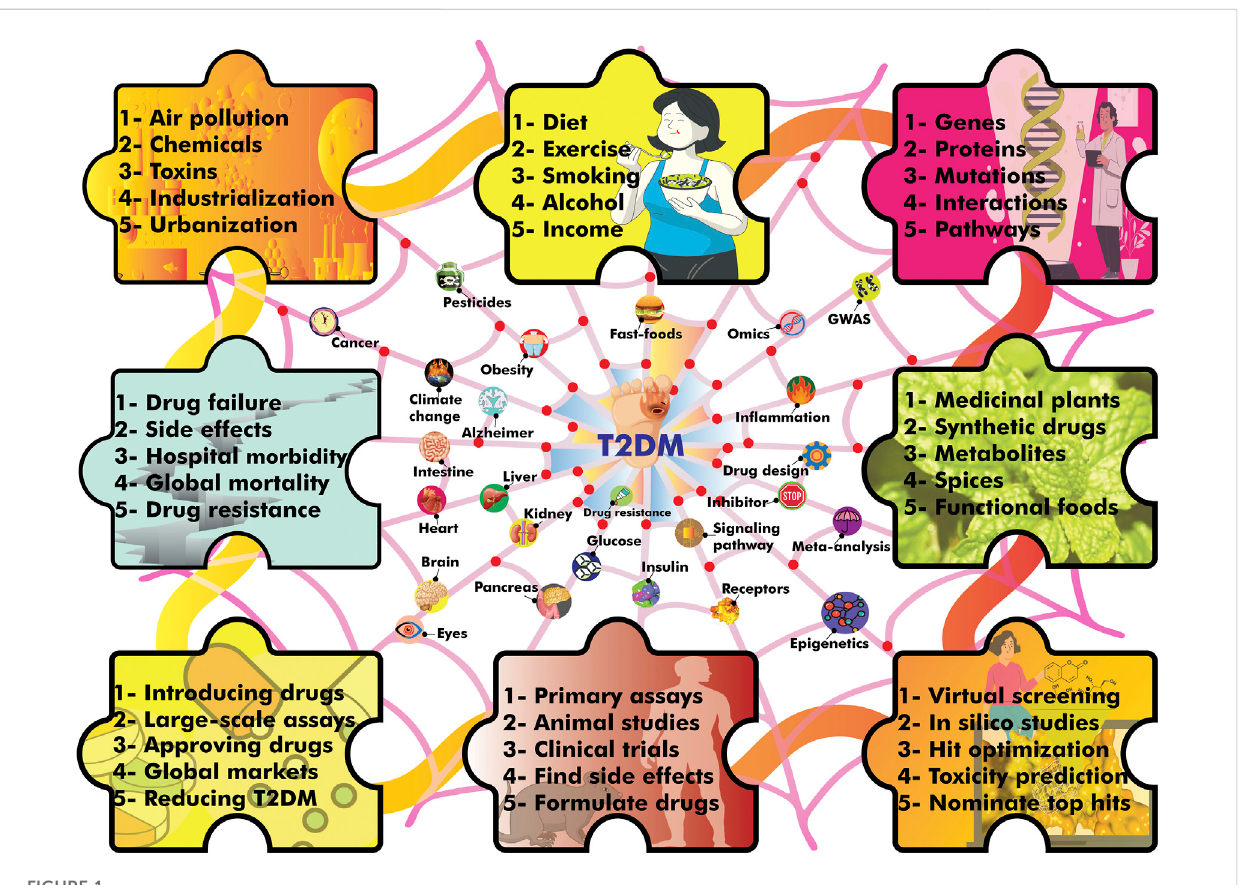
FIGURE 1 A concise depiction of the intricate interplay between environmental and genetic risk factors, lifestyle, efforts for drug design, drug failure and mortality of